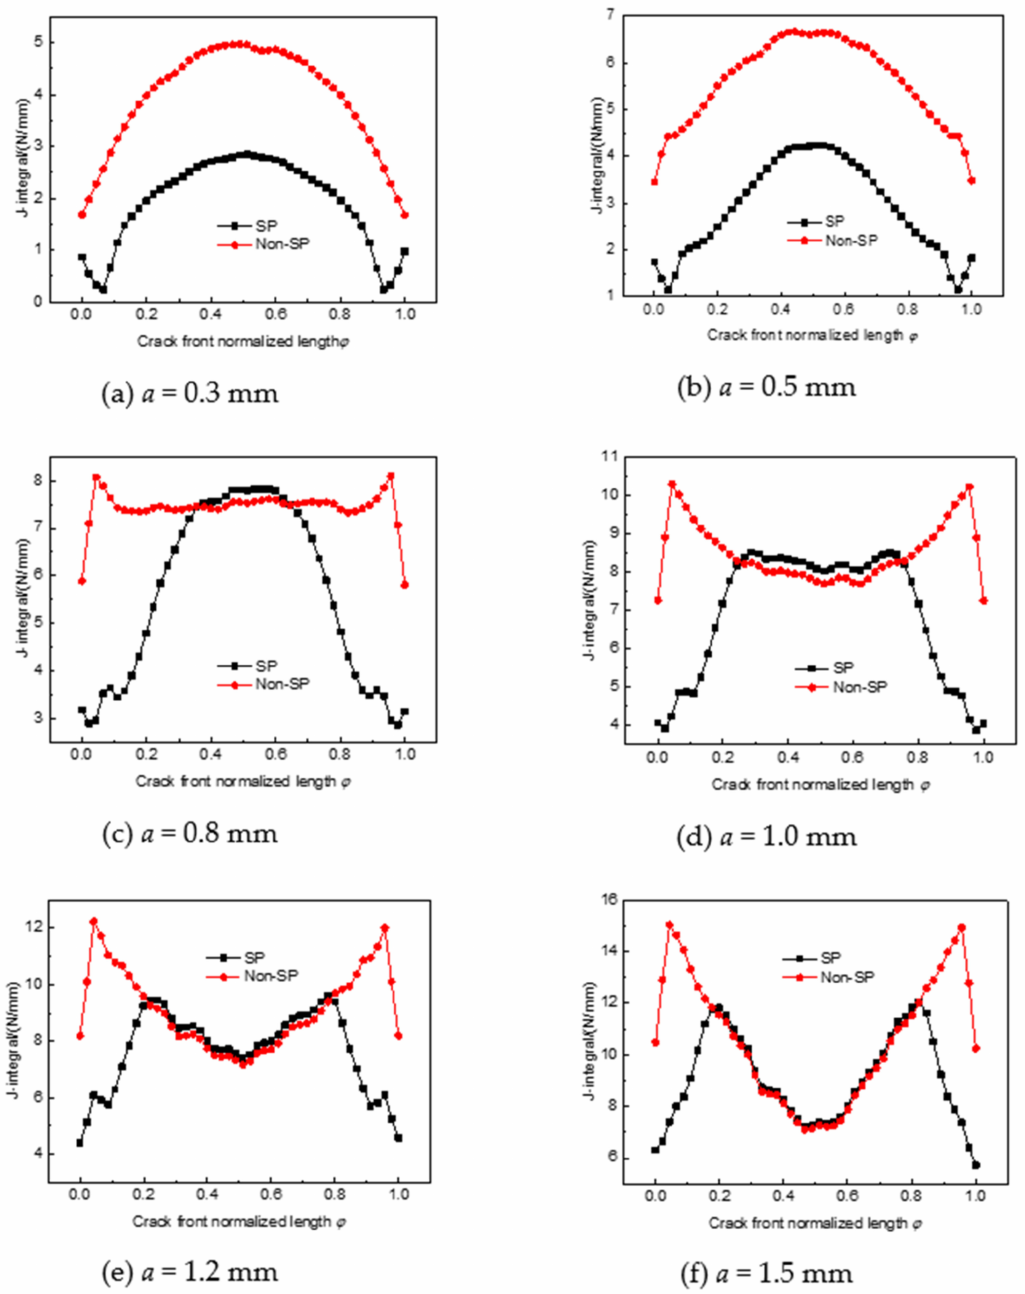
Figure 5. J-integration of crack fronts for peened and non-shot-peened parts. ( a ) a = 0.3 mm; ( b ) a = 0.5 mm; ( c ) a = 0.8 mm; ( d ) a = 1.0 mm; ( e ) a = 1.2 mm; ( f ) a = 1.5